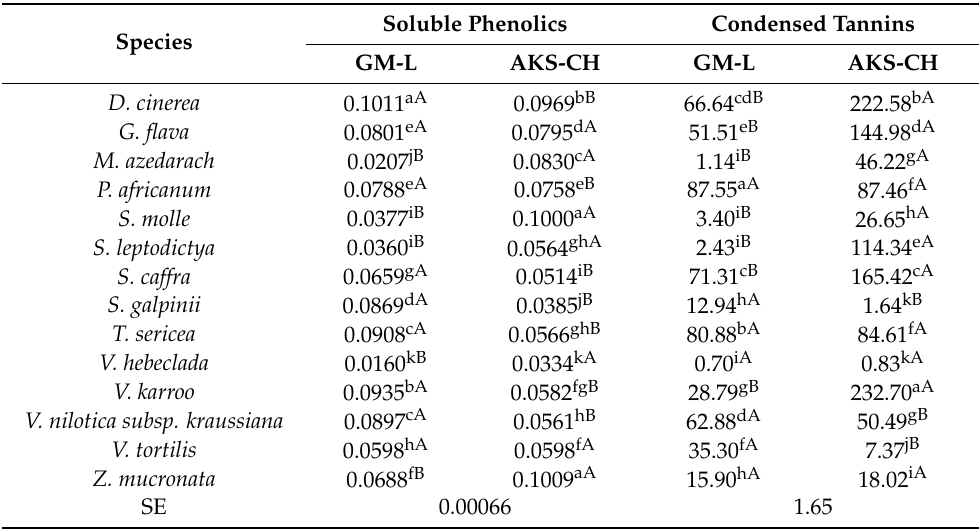
Table 4. Effect of species and soil type on soluble phenolics (SPh, % DM) and condensed tannin (CTs, % DM) of browse species found in GM-L and AKS-CH soil types.